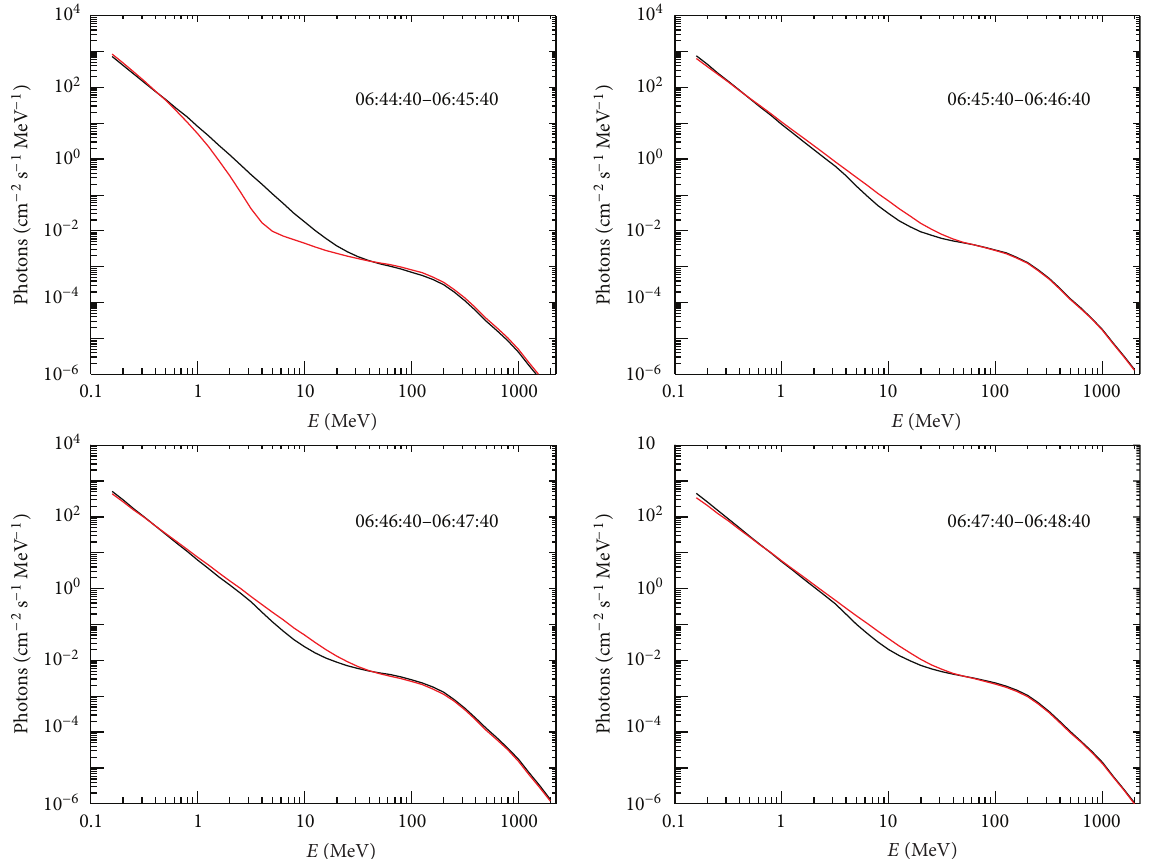
Figure 10: The total energy spectra of photons during the flare on January 20, 2005. The red curves correspond to a power law with varying index and the black curves correspond to a power law with an exponential